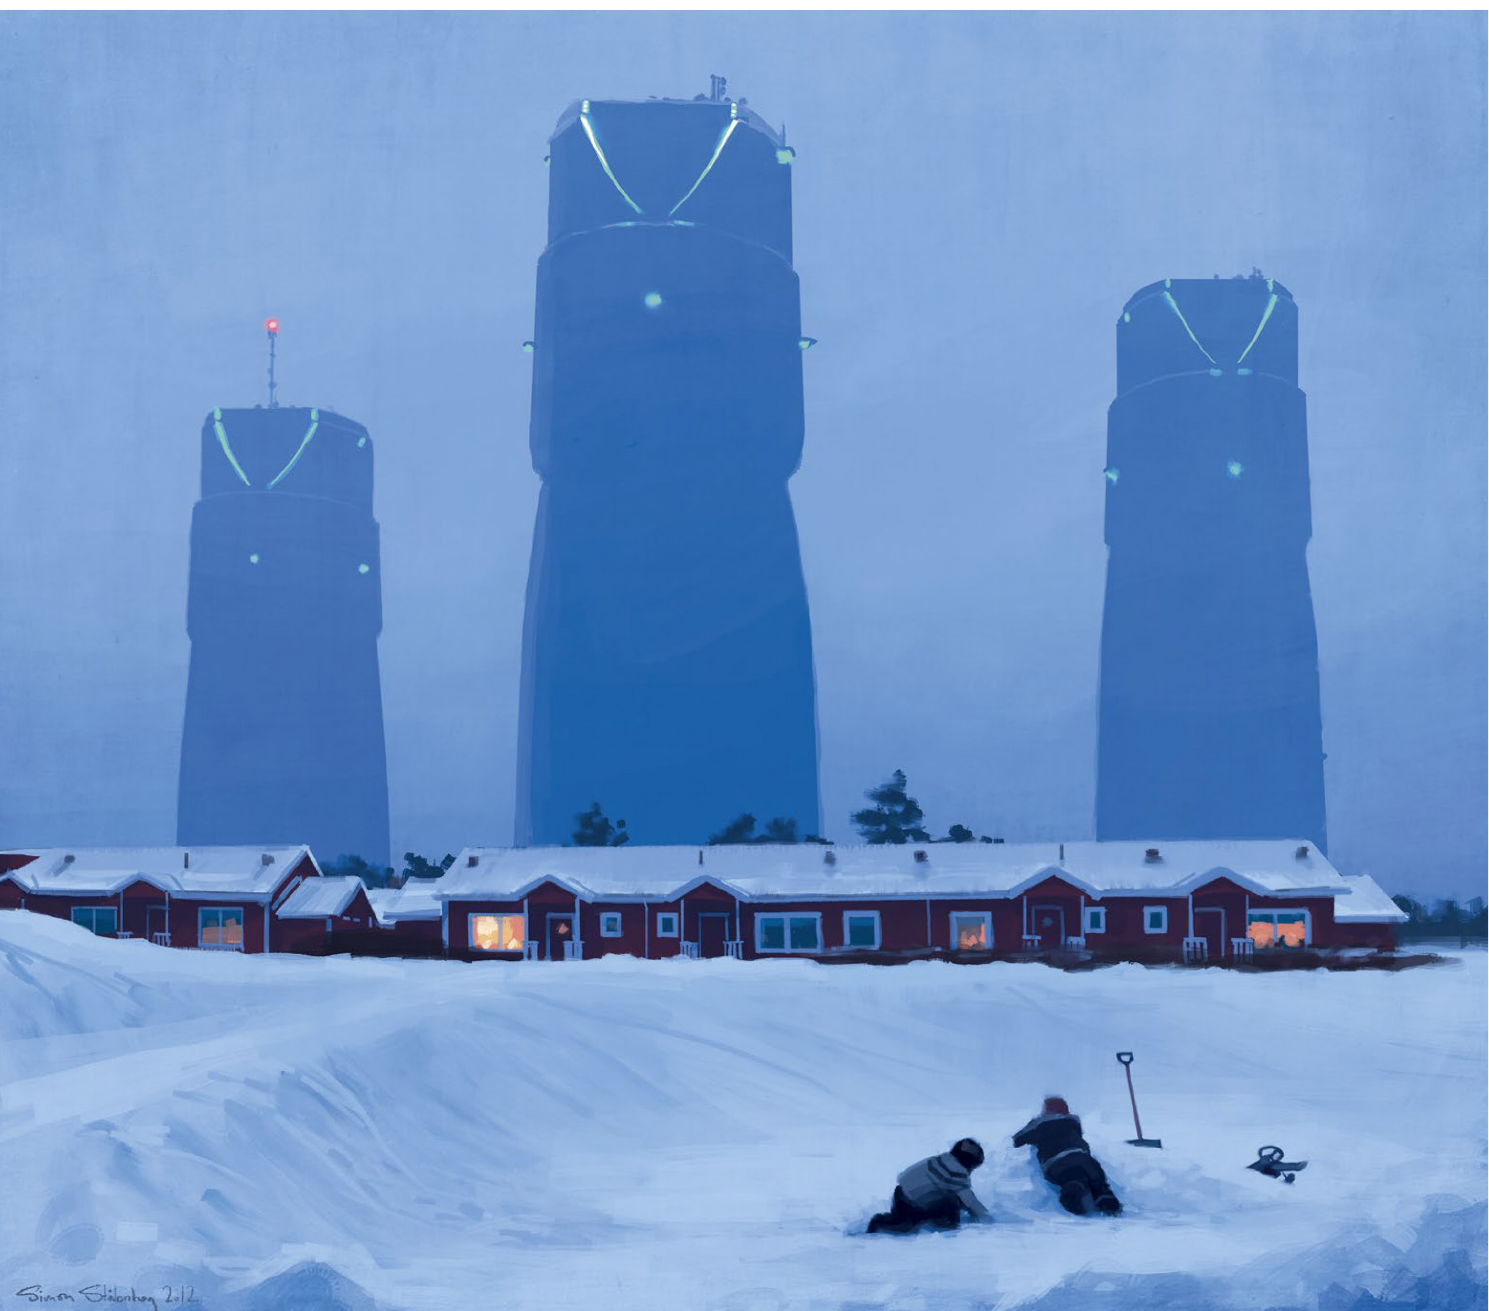
Megastructures and nostalgia for the